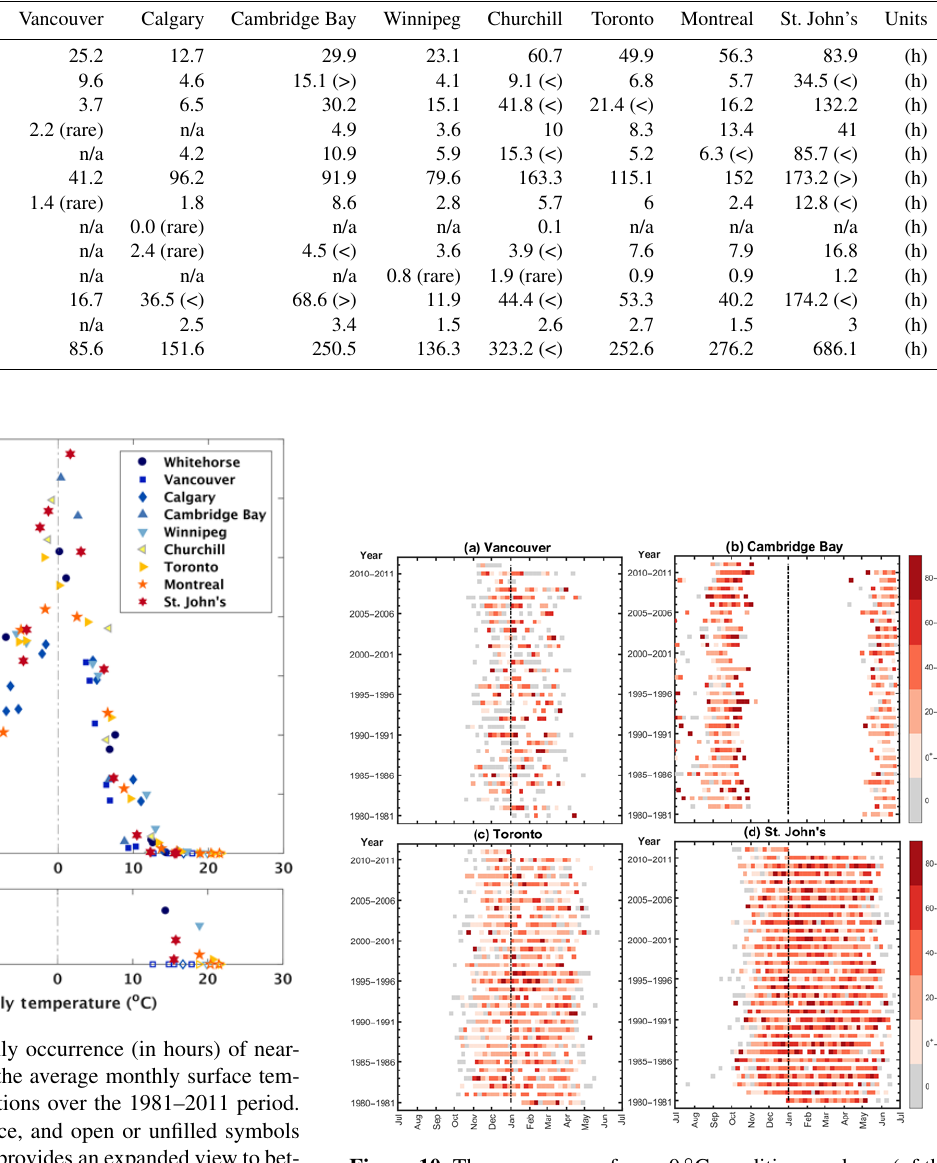
Figure 10. The occurrence of near-0 ◦ C conditions and any (of the 12) associated precipitation types at (a) Vancouver, (b) Cambridge Bay, (c) Toronto, and (d) St. John’s over the 1981–2011 period. Shading refers to the weekly fraction (%) of near-0 ◦ C hours with (or without) precipitation; the “0 + ” symbol refers to at least 1h of precipitation; and the grey “0” denotes no precipitation, even if the near-0 ◦ C criterion was met. Blank areas indicate no occurrence of near-0 ◦ C conditions. The vertical, dashed line indicates 1